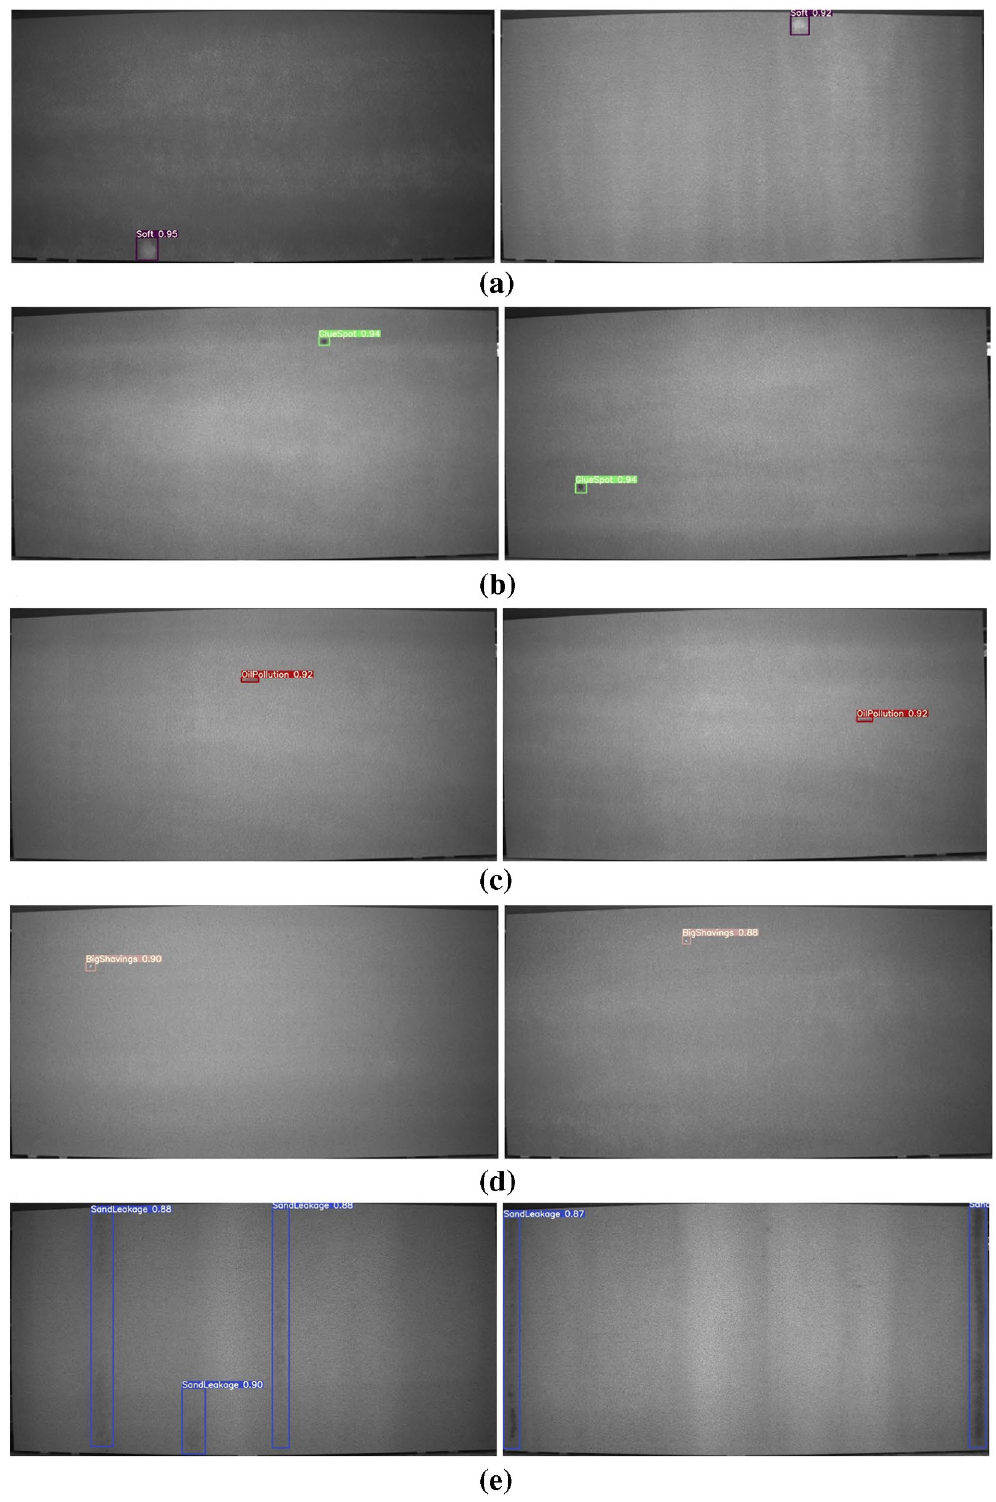
Figure 8. Surface defect detection results of particleboard based on PB-YOLOv5s algorithm: ( a ) Soft defect, ( b ) GlueSpot defect, ( c ) OilPollution defect, ( d ) BigShavings defect, ( e ) SandLeakage